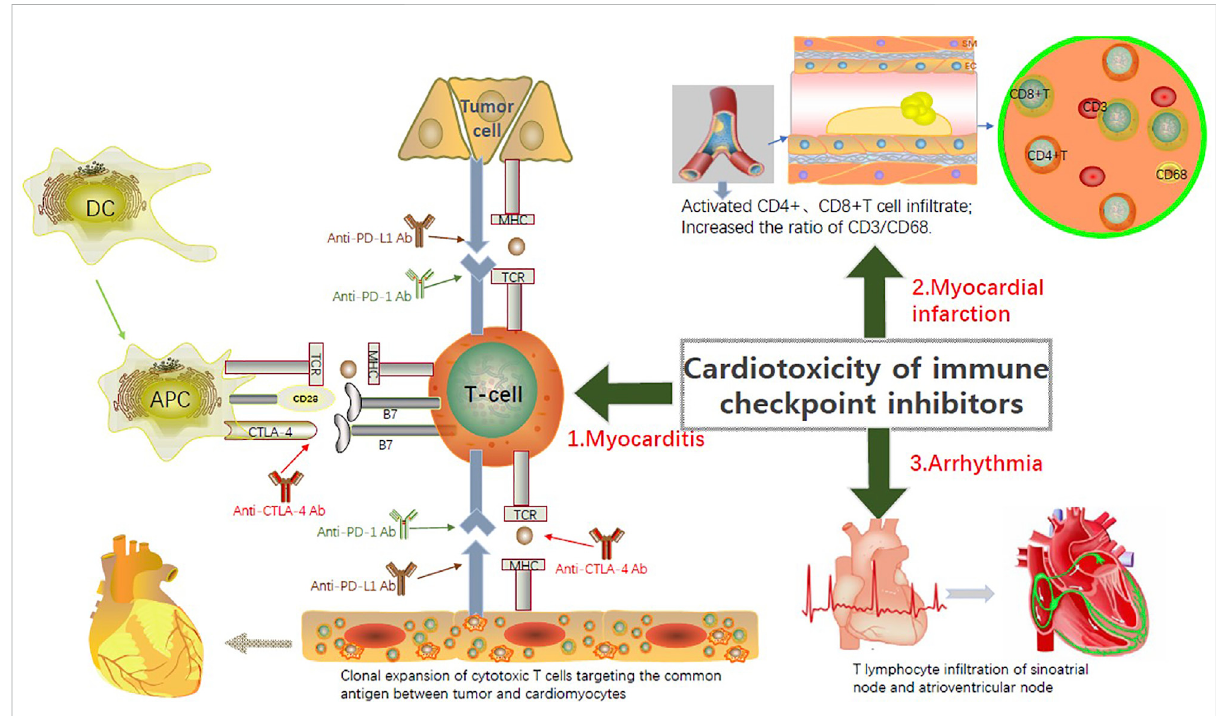
Currently recognized pathogenic mechanisms of the ICIs-related Cardiotoxicity. PD-L1 exists in cardiomyocytes and can be upregulated by a variety of cytokines, including interferon, tumor necrosis factor- α , and vascular endothelial growth factor. During ICI treatments, immunosuppressive effects mediated by the “ PD-1 - PD-L1 axis ” are hindered, resulting in the development of ICI-related cardiotoxicity. Although the underlying pathophysiological mechanism of ICI-related myocarditis is not totally understood, the in fi ltration of T cells into the injured myocardial tissue is recognized as the major pathogenic mechanism. ICI-associated in fl ammation and T cell activation-induced coronary vasculitis contribute to the myocardial infarction after ICI treatments. New arrhythmia is believed to be directly related to T cell-mediated cytotoxicity associated with the use of